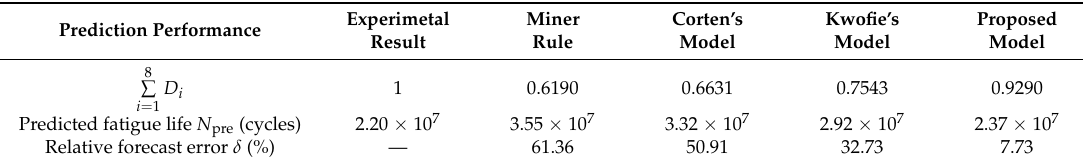
Table 8. Prediction performances of Miner rule, Corten’s model, Kwofie’s model, and the proposed model for CFD2